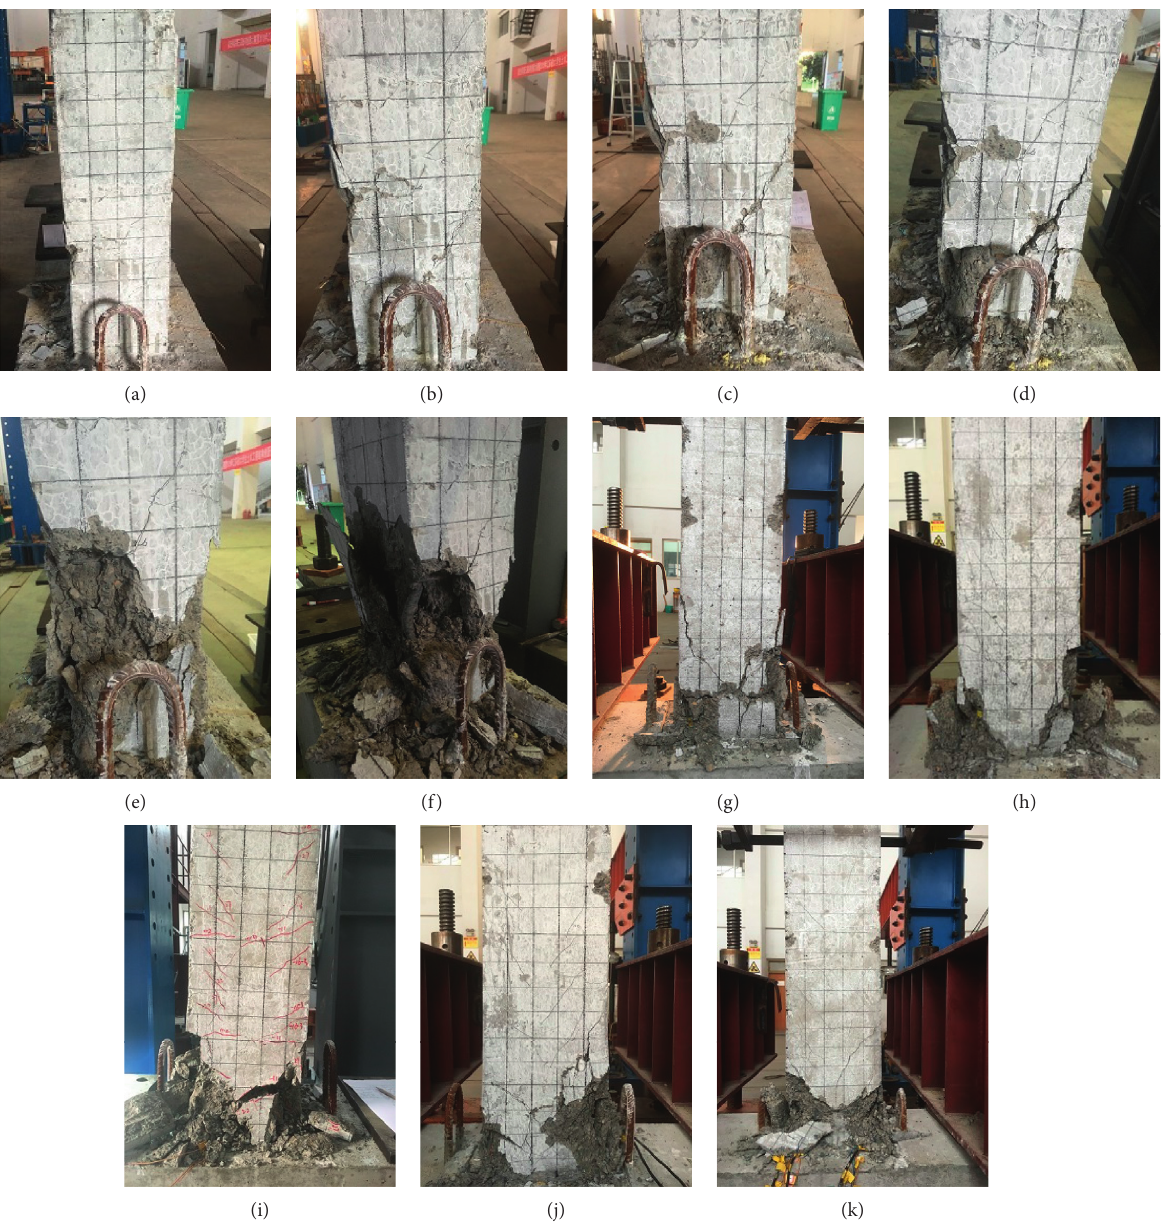
Figure 3: Failure mode of specimens. (a) SRC4 (1.5%). (b) SRC4 (2.0%). (c) SRC4 (2.5%-1st). (d) SRC4 (2.5%-6th). (e) SRC4 (2.5%-10th). (f) SRC4 (failure). (g) SRC1. (h) SRC2. (i) SRC3. (j) SRC1-2. (k)